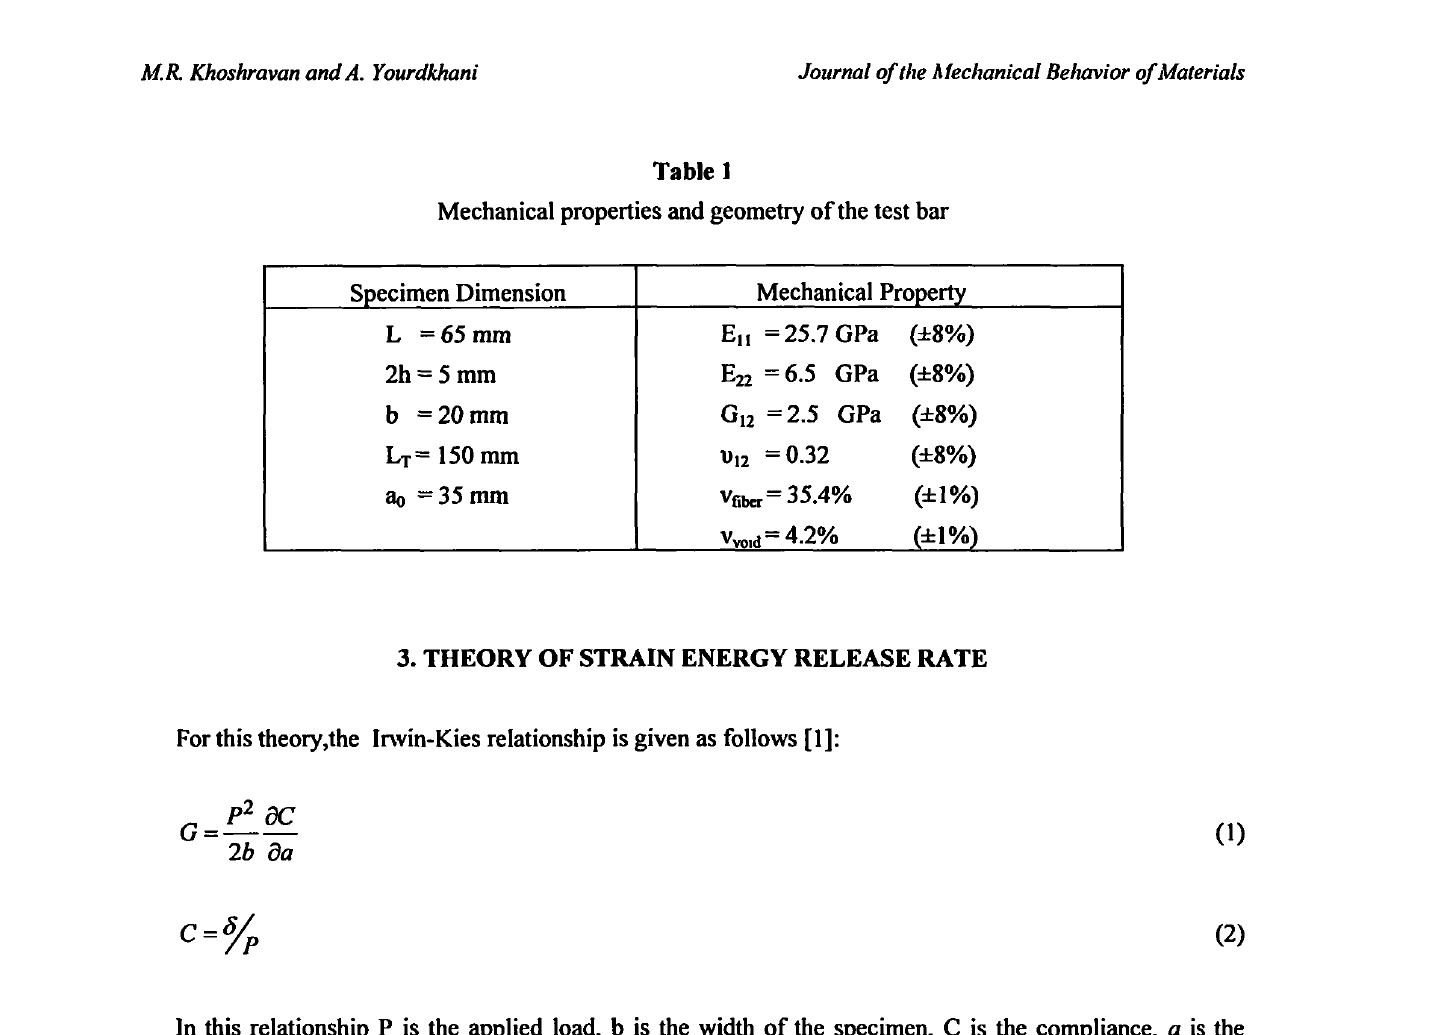
Mechanical properties and geometry of the test